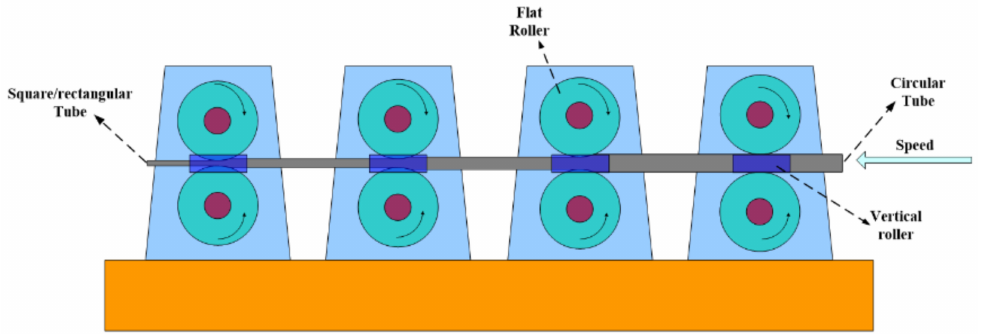
Figure 1. Diagram of a circular tube roll forming a rectangular